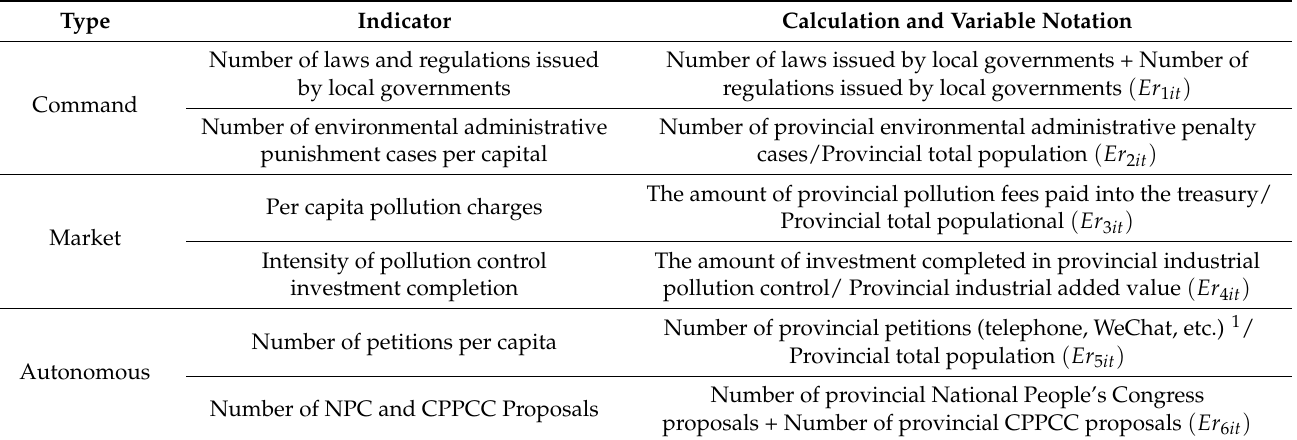
Table 2. Three types of environmental regulation tools variable